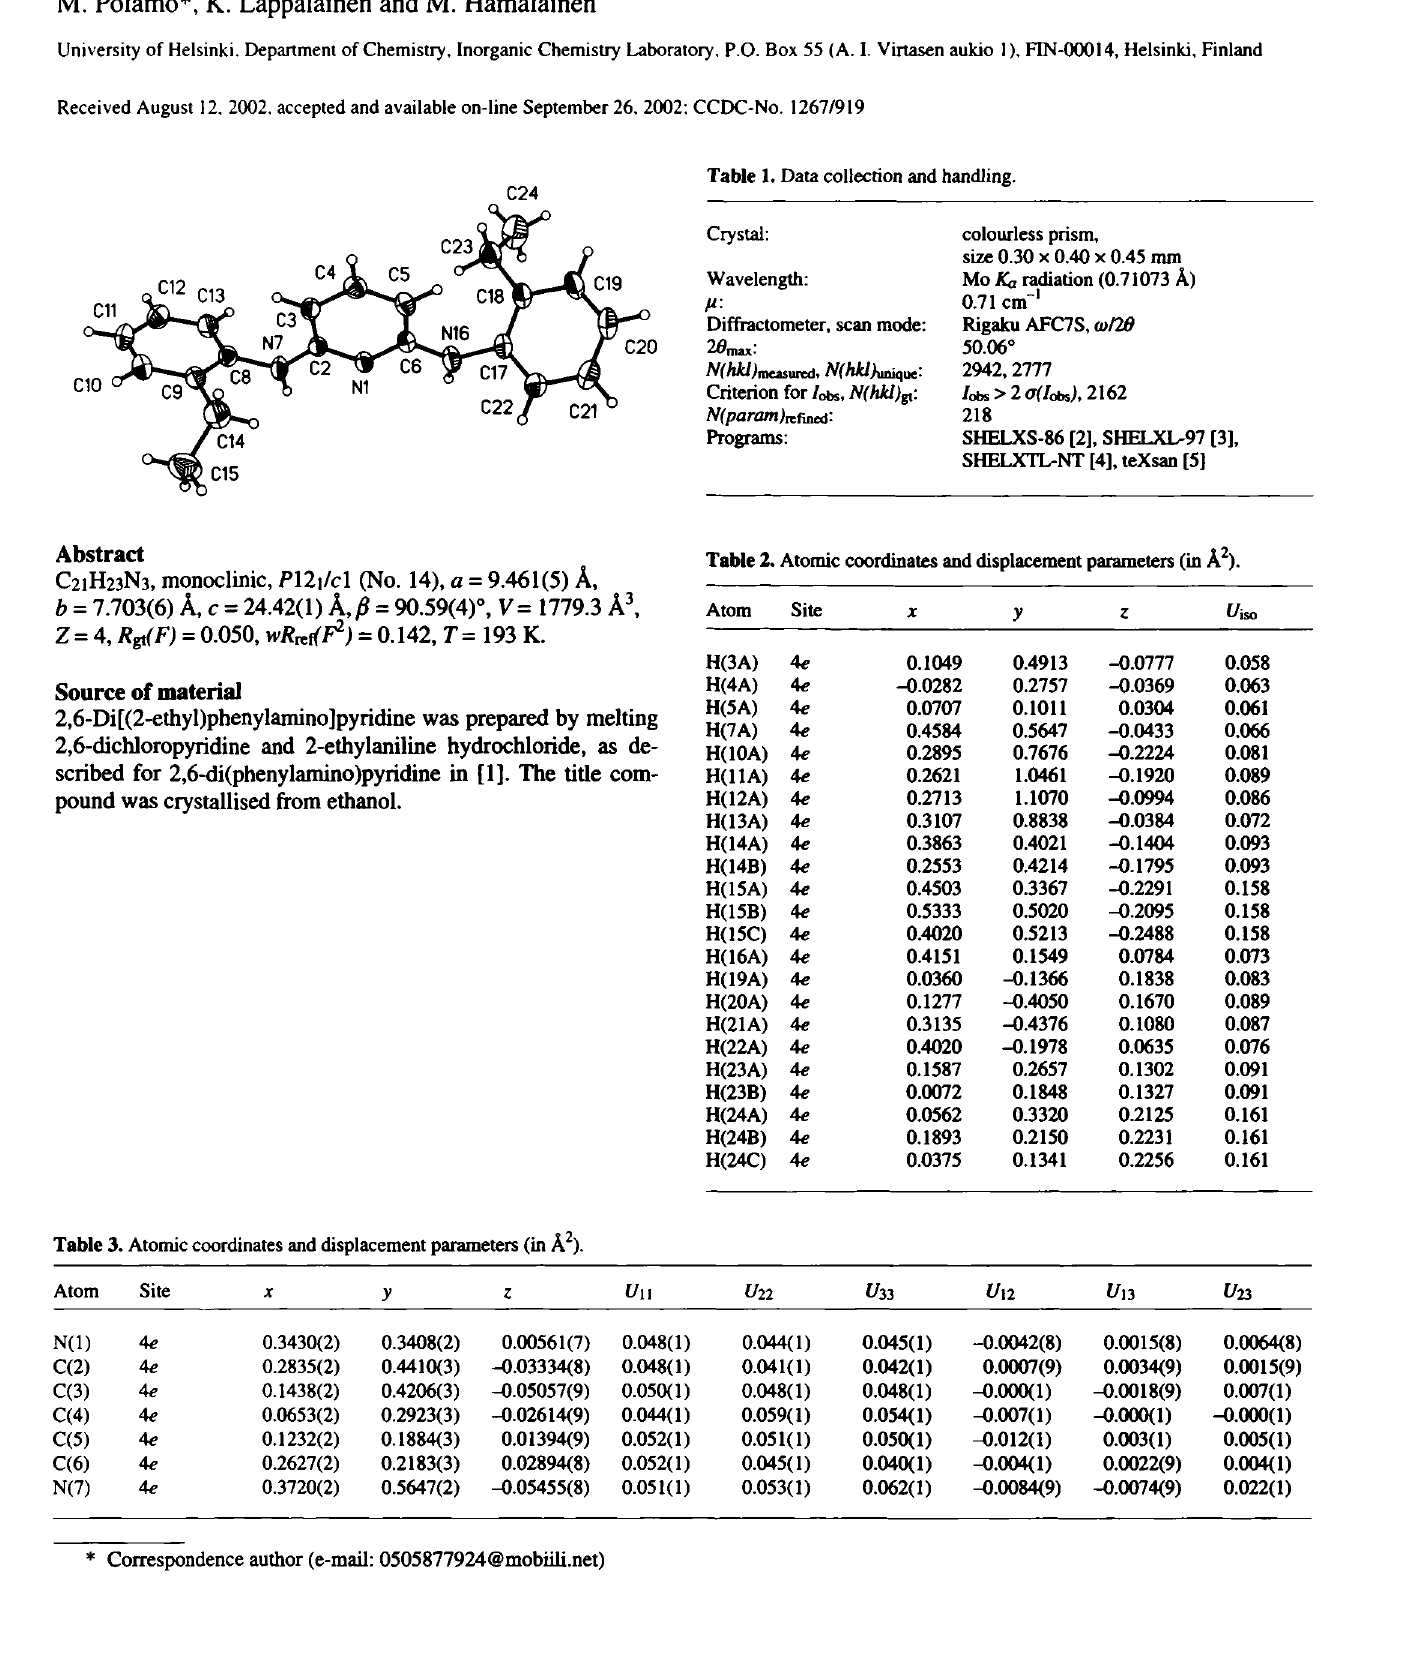
Table 2. Atomic coordinates and displacement parameters (in Â 2 ).